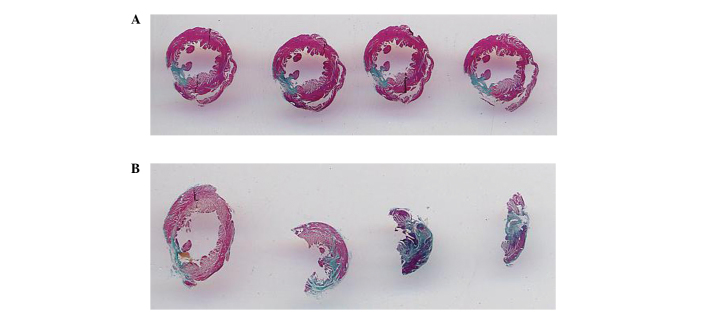
Staining for collagen. (A) Collagen fibers staining and (B) partial collage fiber staining in New Zealand myocardial infarction rabbit models. Pink staining, normal myocardium; blue-grey staining; infarct areas of the myocardium.